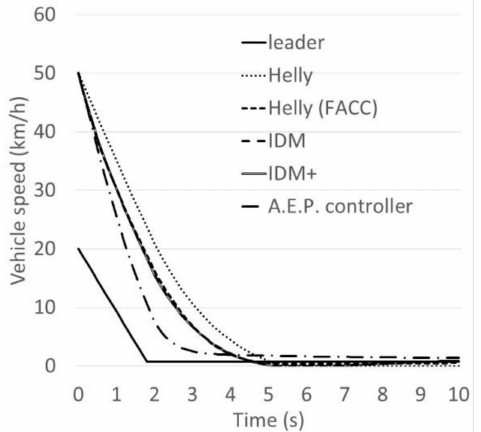
Figure 9. The following vehicle’s speed transition of case